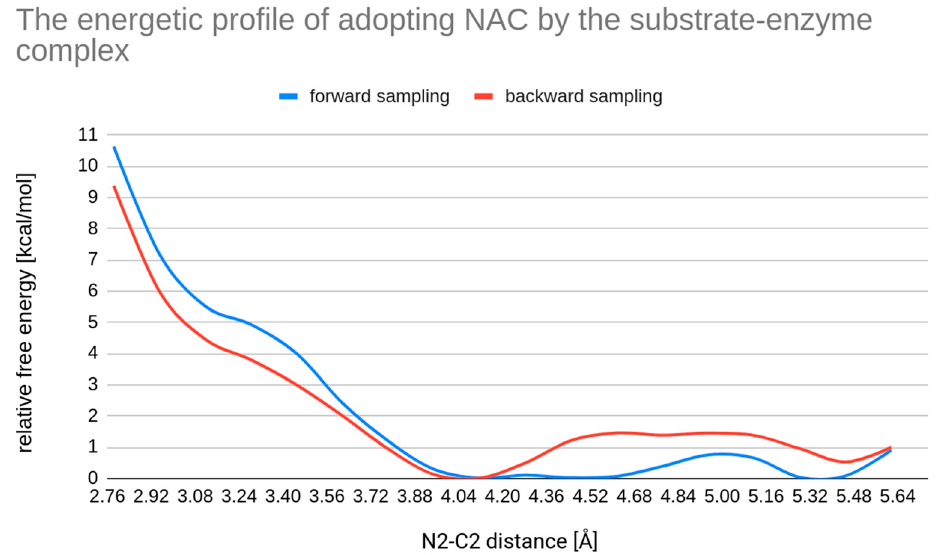
Figure 10. The free energy changes (PMF profile) for the C2-N2 distance for the model with the Trp21-B conformation: forward (from 5.7 to 2.7 Å) ( blue ) and backwards (from 2.7 to 5.7 Å) ( red ).